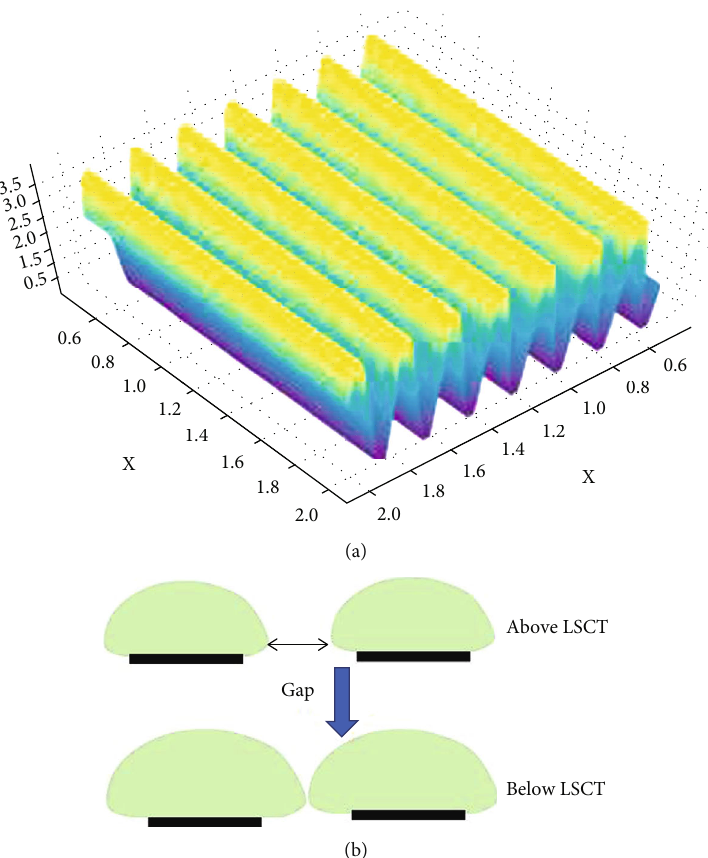
Figure 10: (a) a contour plot of the patterning intensities during interferometric patterning; (b) the schematic of the excess width grown on the patterned